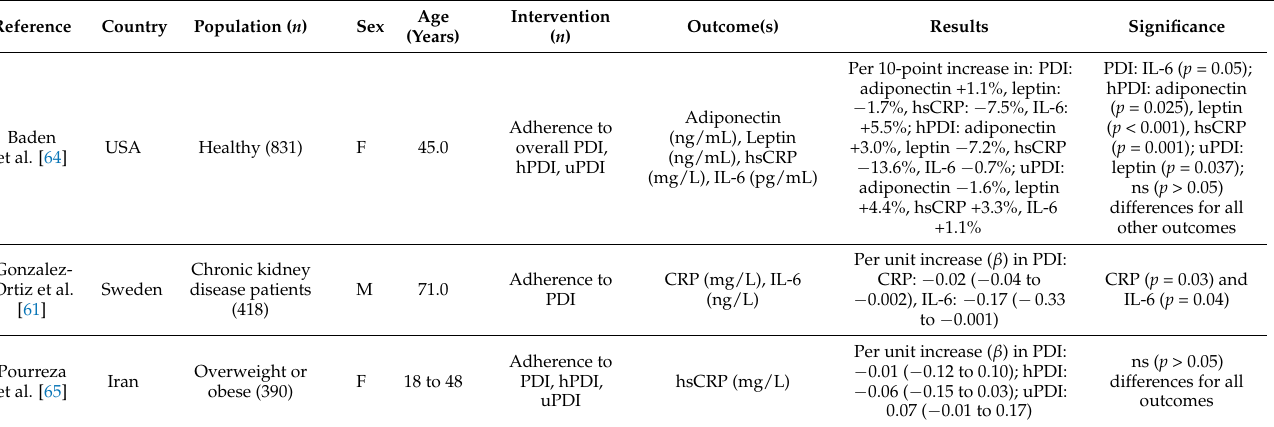
Table 9. Cross-Sectional Studies of Plant-Based Diet Indices and Inflammatory